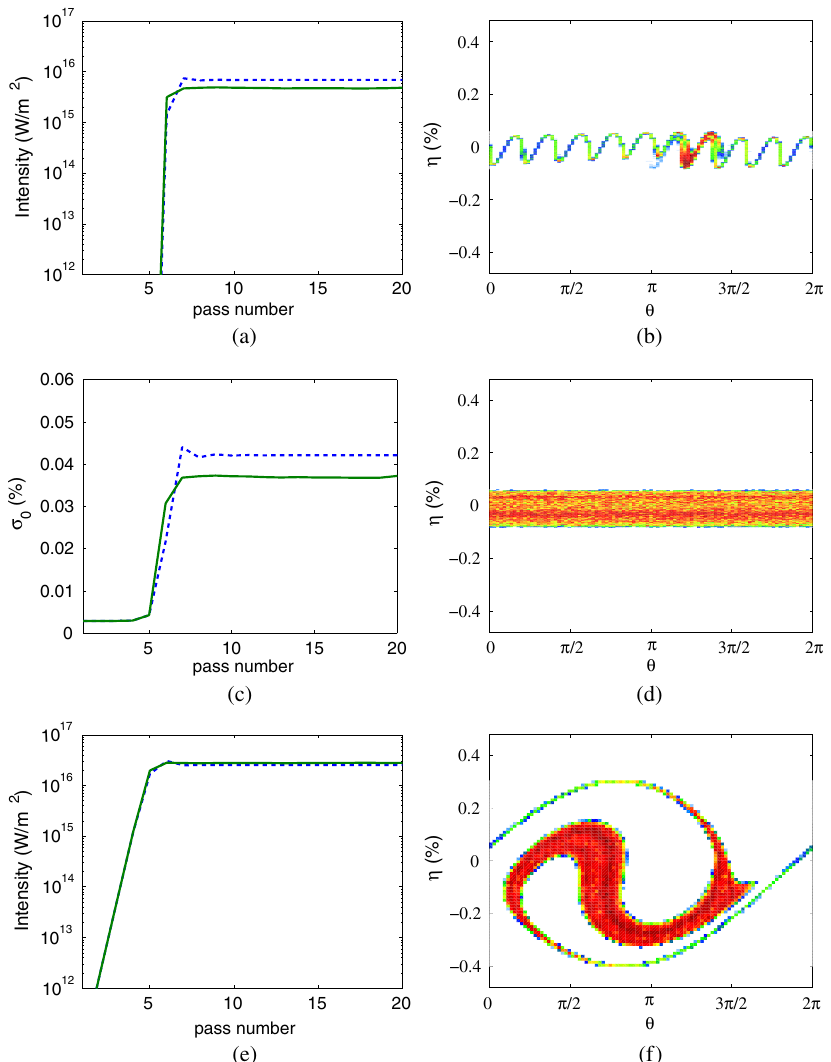
FIG. 6. A comparison of the map (dashed line) to a one-dimensional simulation (solid line), and equilibrium longitudinal phase spaces for key points along the target radiation generation and oscillator sections of the radiator-first scheme with red areas indicating higher phase space density. Note that the energy scale for the phase space diagrams here is 12 (cid:7) larger than for those of Fig. 5: (a) intensity of radiation at 1.34 nm exiting radiator; (b) phase space at the end of the radiator; (c) energy spread entering the oscillator; (d) phase space entering the oscillator; (e) intensity of 13.4 nm radiation at the end of the oscillator; and (f) phase space at the end of the oscillator.